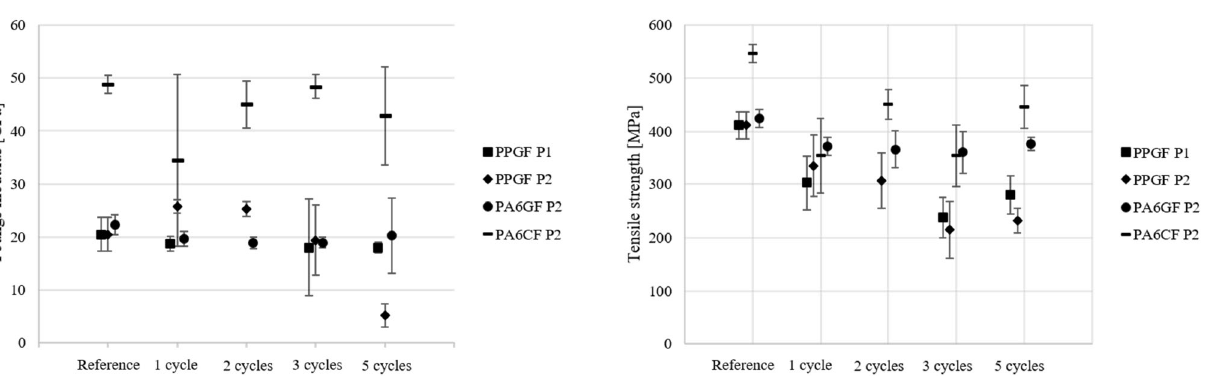
Fig. 9 Tensile test results for Young’s modulus Fig. 10 Tensile test results for tensile